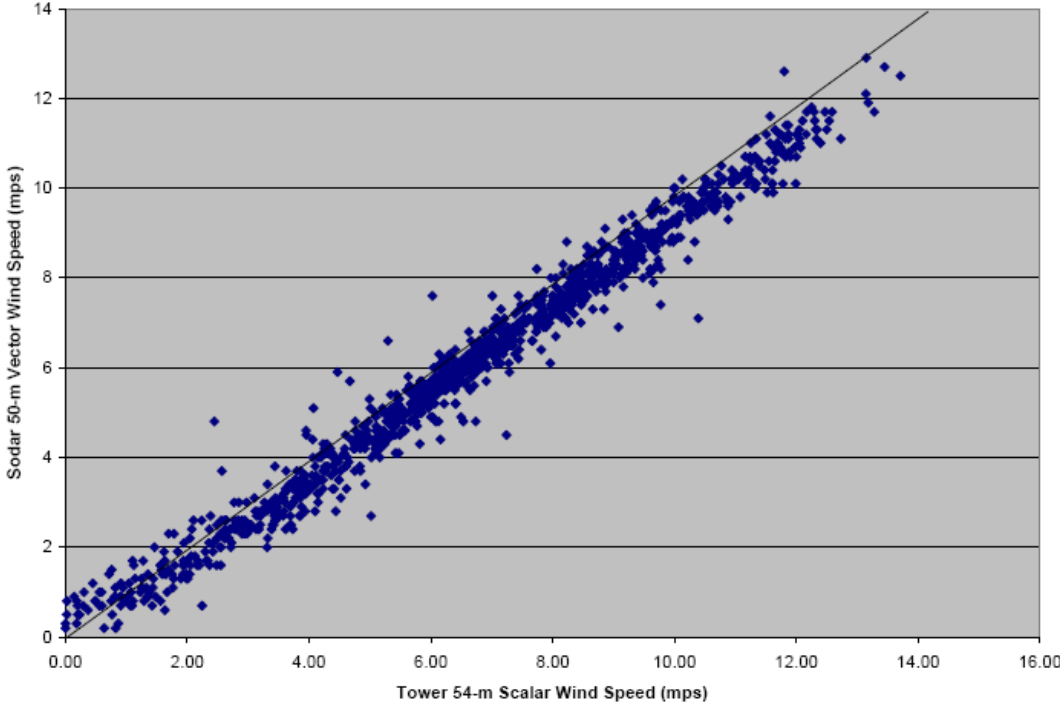
Figure 7. Scatter plot showing the correlation of the sodar-measured (vector) wind speed at 50 m and the anemometer-measured (scalar) wind speed at 54 m above ground level. Courtesy of Atmospheric Research and Technology, Inc. Reproduced with permission